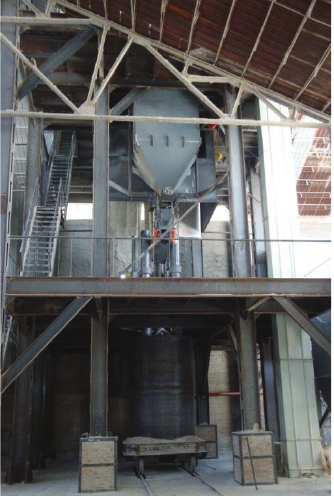
Figure 17: Arm-type electro-fused magnesia furnace.